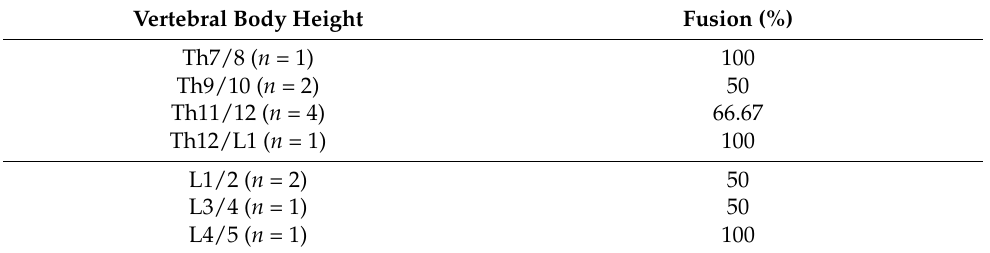
Table 2. Bony fusion of cage implantation and different vertebral body heights.